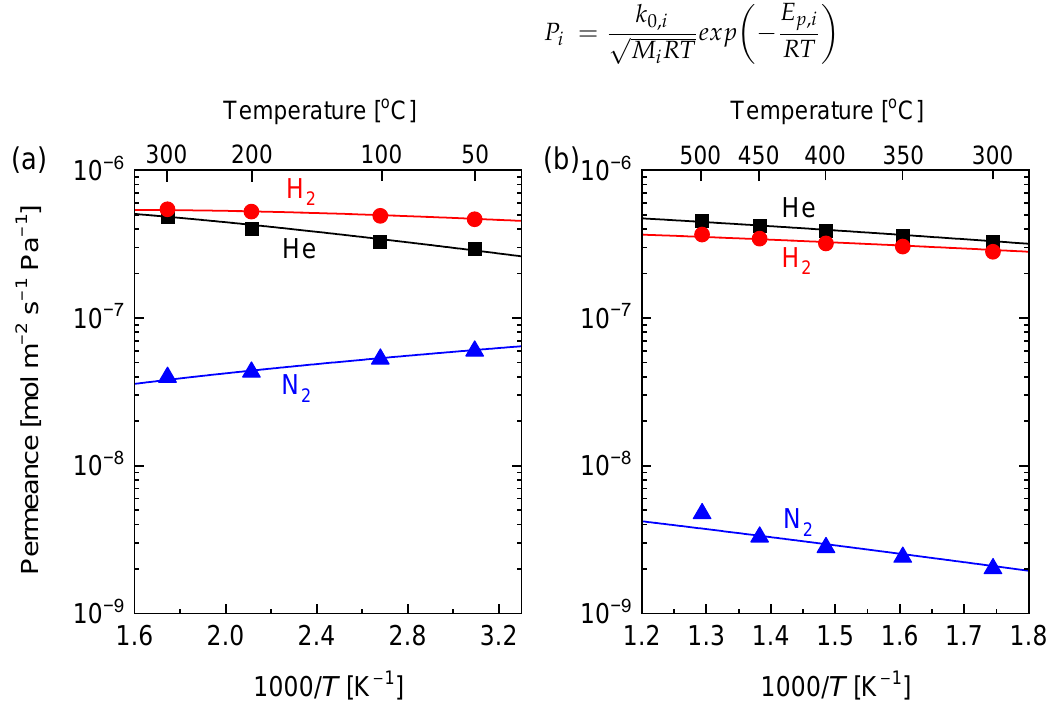
Figure 8. Temperature dependence of the He, H 2 and N 2 permeance of carbon-SiO 2 -ZrO 2 membranes prepared at ( a ) 550 and ( b ) 750 °C. Table 1. Carbon-SiO 2 -ZrO 2 membrane properties determined from the temperature dependence of He, H 2 , and N 2 permeance values .